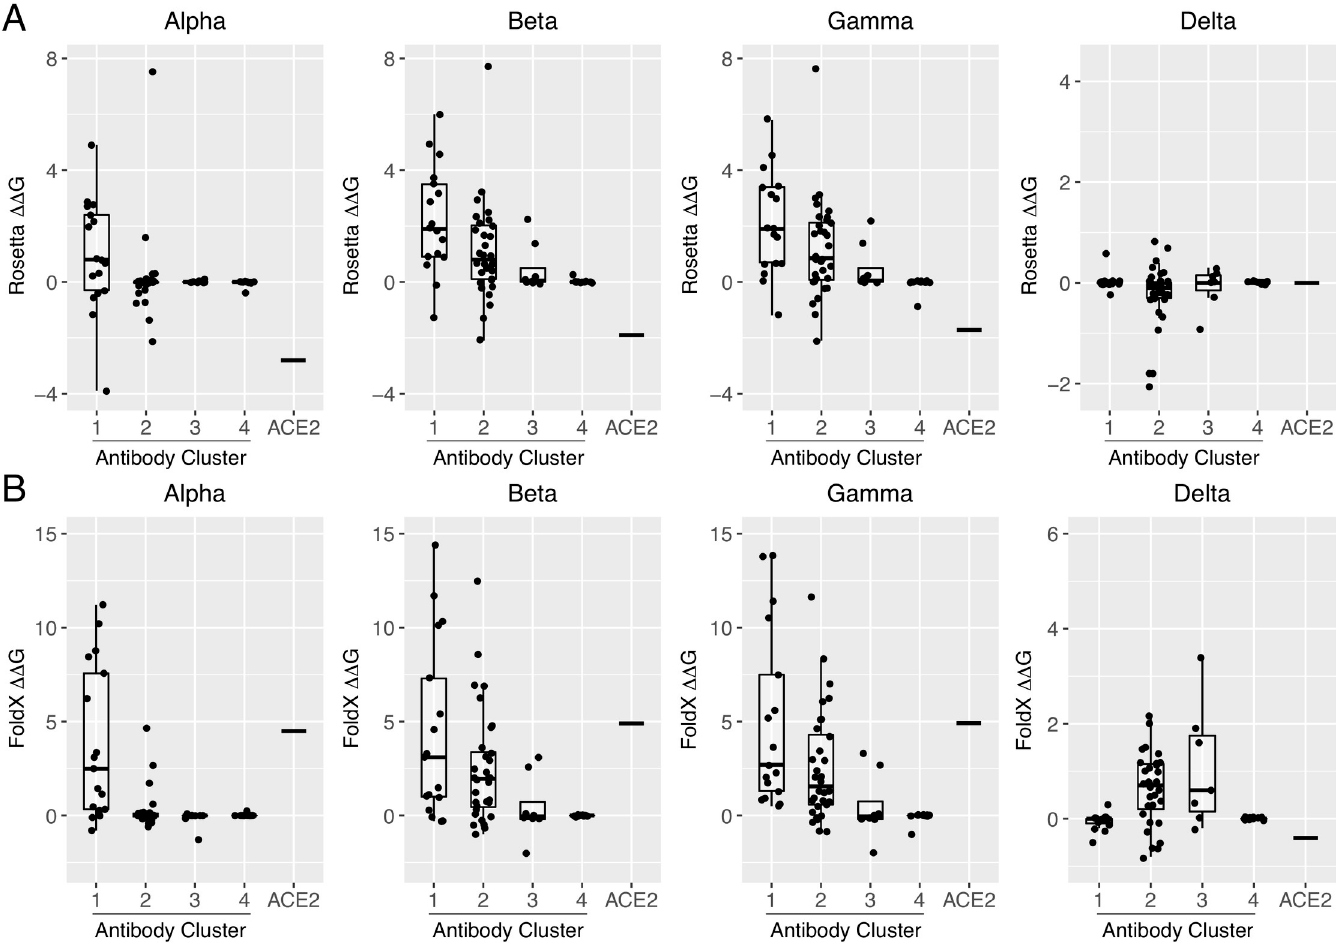
Fig 8. Profiling antibody and receptor RBD binding effects for circulating SARS-CoV-2 variants. Computational mutagenesis was used to predict binding affinity effects ( ΔΔ Gs) of SARS-CoV-2 variants of concern Alpha (B.1.1.7; RBD substitution N501Y), Beta (B.1.351; RBD substitutions K417N, E484K, N501Y), Gamma (P.1; RBD substitutions K417T, E484K, N501Y), and Delta (B.1.617.2; RBD substitutions L452R, T478K), using (A) Rosetta and (B) FoldX. ΔΔ G values are shown as boxplots grouped by antibody clusters or ACE2 receptor, with all antibody ΔΔ G values shown as points, and the ACE2 ΔΔ G value represented as a horizontal bar in each boxplot. Both Rosetta and FoldX ΔΔ G values are commensurate with energies in kcal/mol.